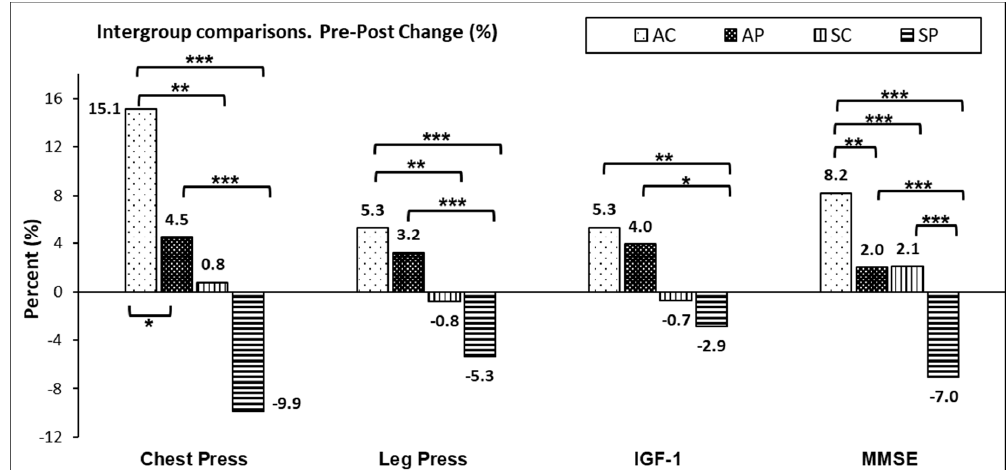
(* p < 0.05; ** p < 0.01; *** p < 0.001). AC: Active Clean; AP: Active Pollution; SC: Sedentary Clean; SP: Sedentary